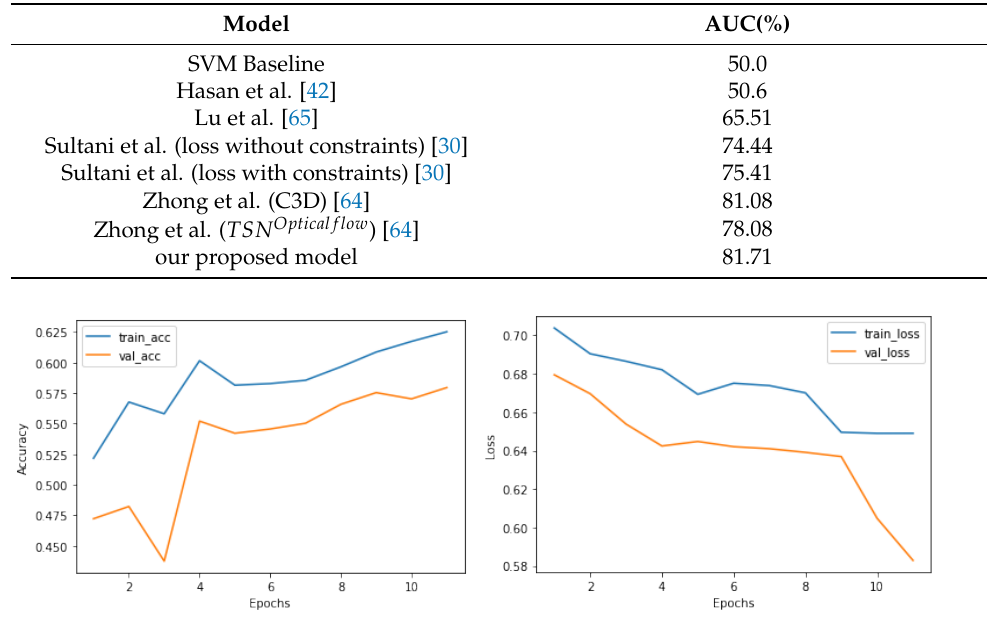
Table 5. AUC for binary classification on the UCF-Crime dataset.